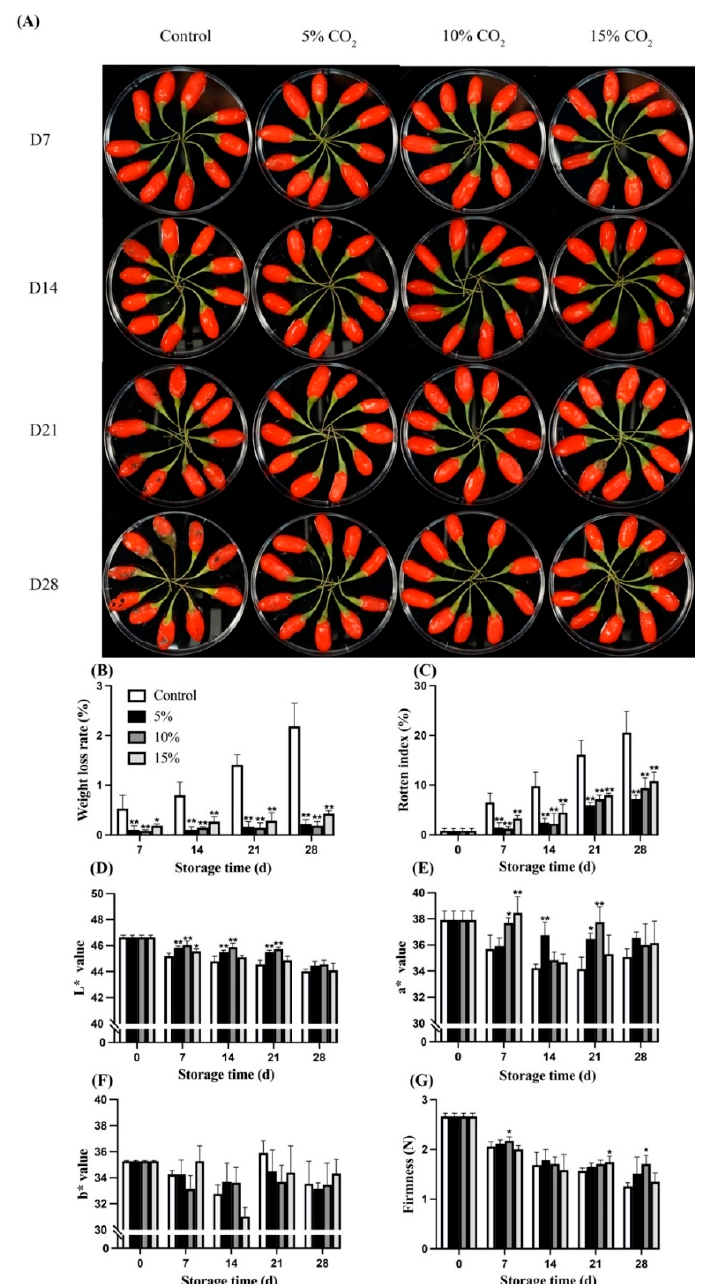
Figure 1. Morphology of wolfberry in response to elevated CO 2 during storage at 0 ± 0.5 °C for 28 d ( A ), and the effects of elevated CO 2 on weight loss ( B ), rotten index ( C ), L* value ( D ), a* value ( E ), b* value ( F ), and firmness ( G ) of wolfberry during storage at 0 ± 0.5 °C for 28 d. Significant level * p < 0.05; ** p < 0.01.